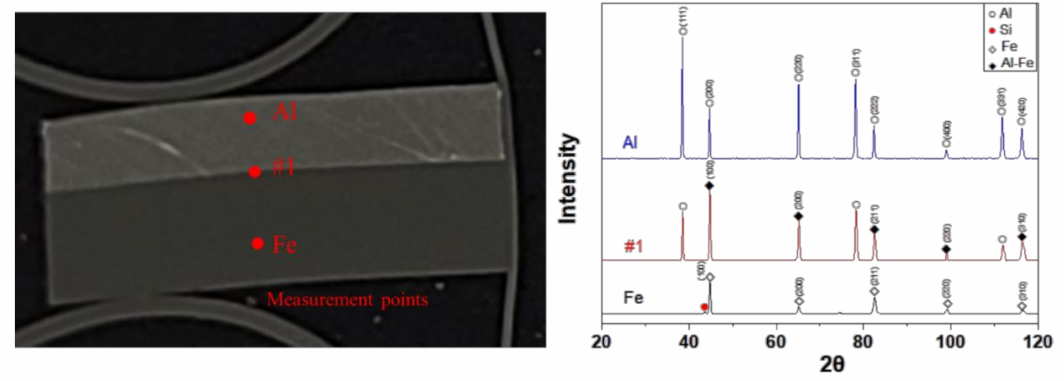
Figure 17. Micro XRD analysis at flyer (Al sheet), interface (#1), and target sheet TRIP1180 sheet).